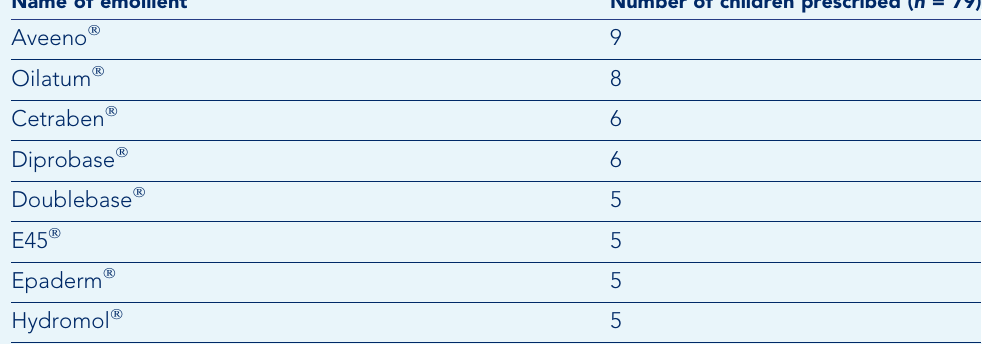
Table S5. Most commonly (reported by two or more participants)